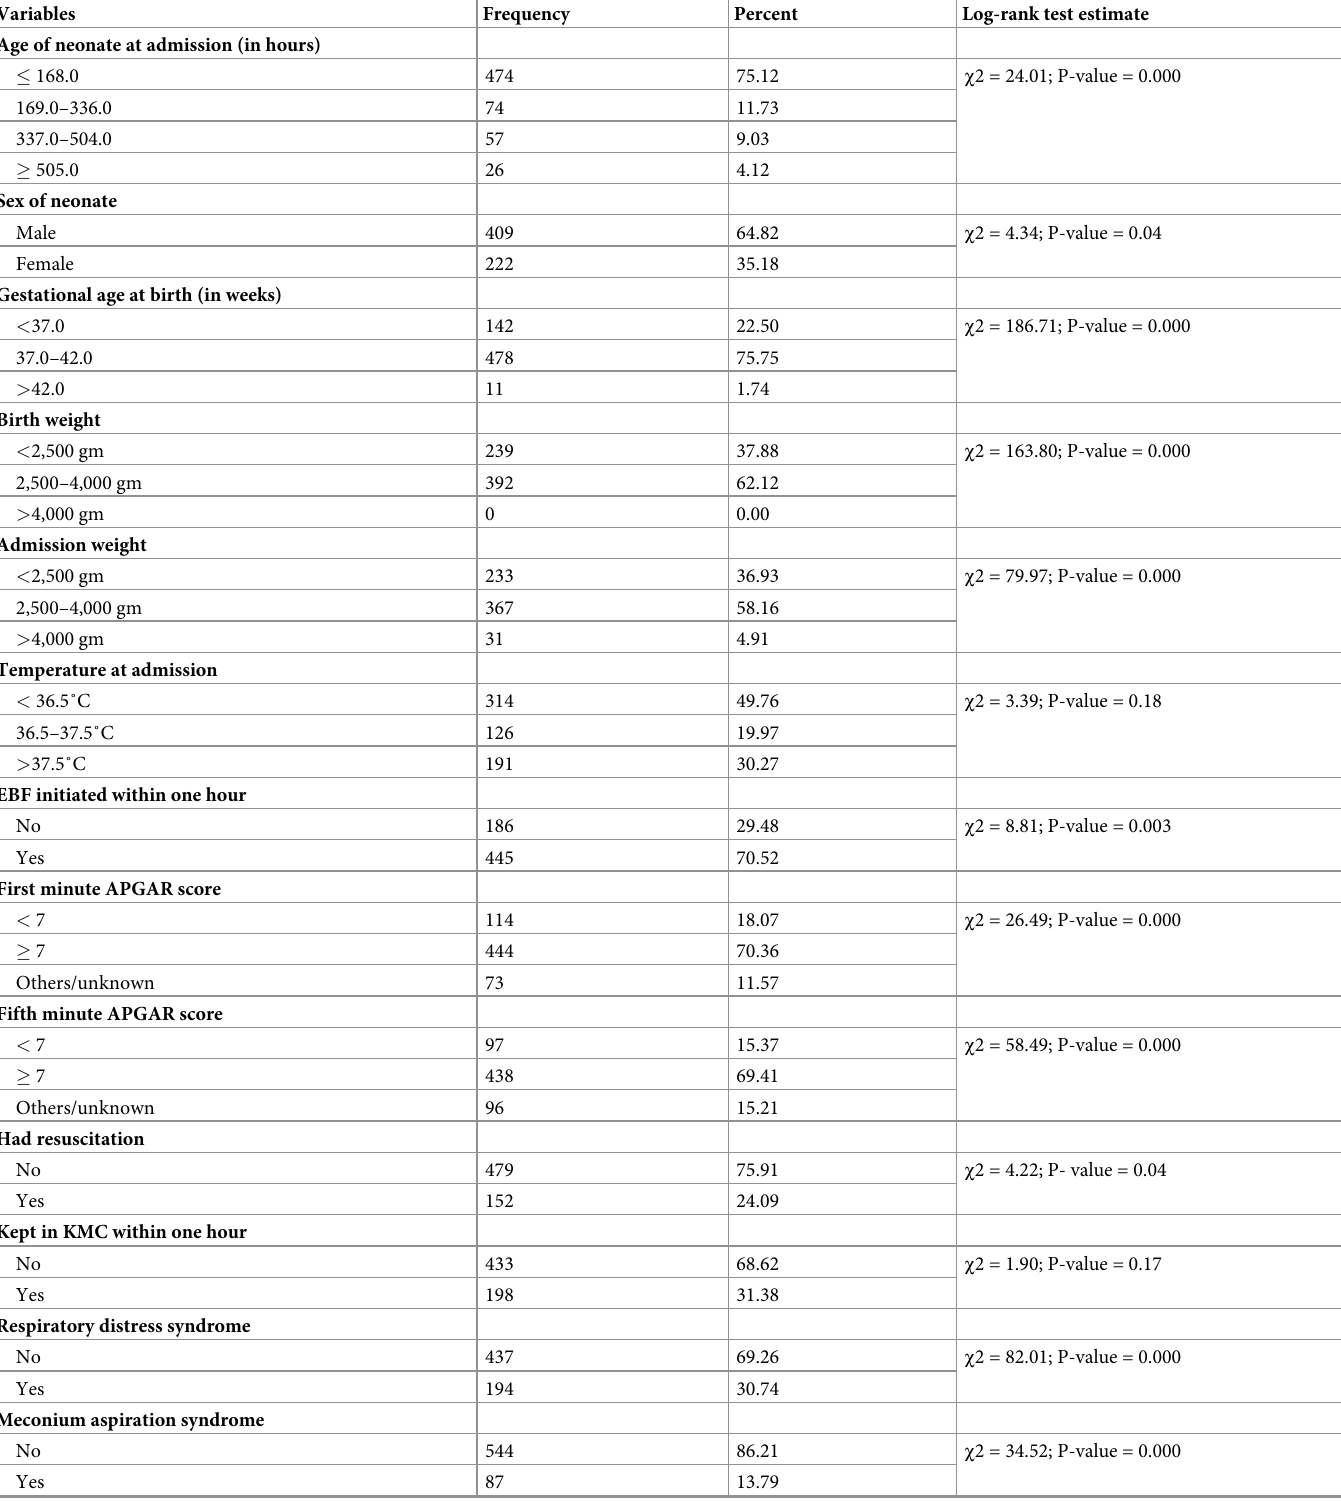
Table 4. Neonate-related characteristics in Public Hospitals of Central Gondar Zone, 2021 (n =